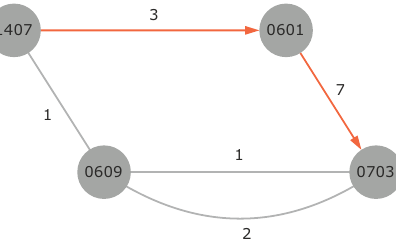
Figure 3. Subset of nodes and their relationships